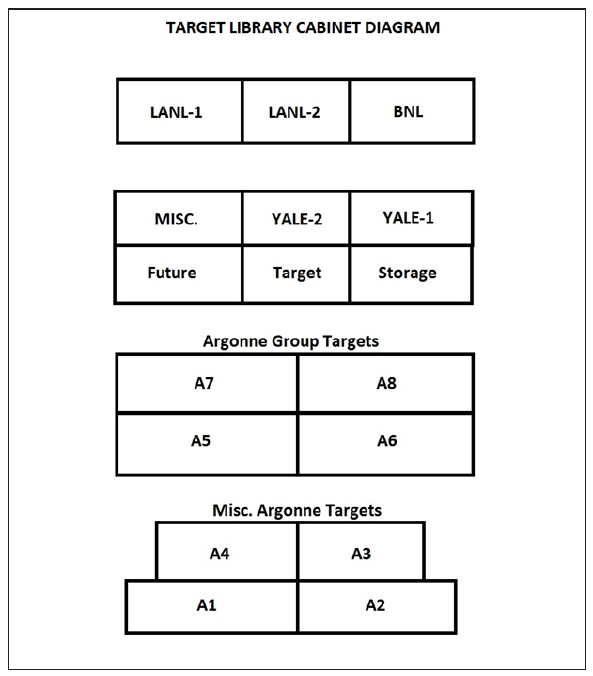
Fig. 1. Schematic layout of the Argonne Target